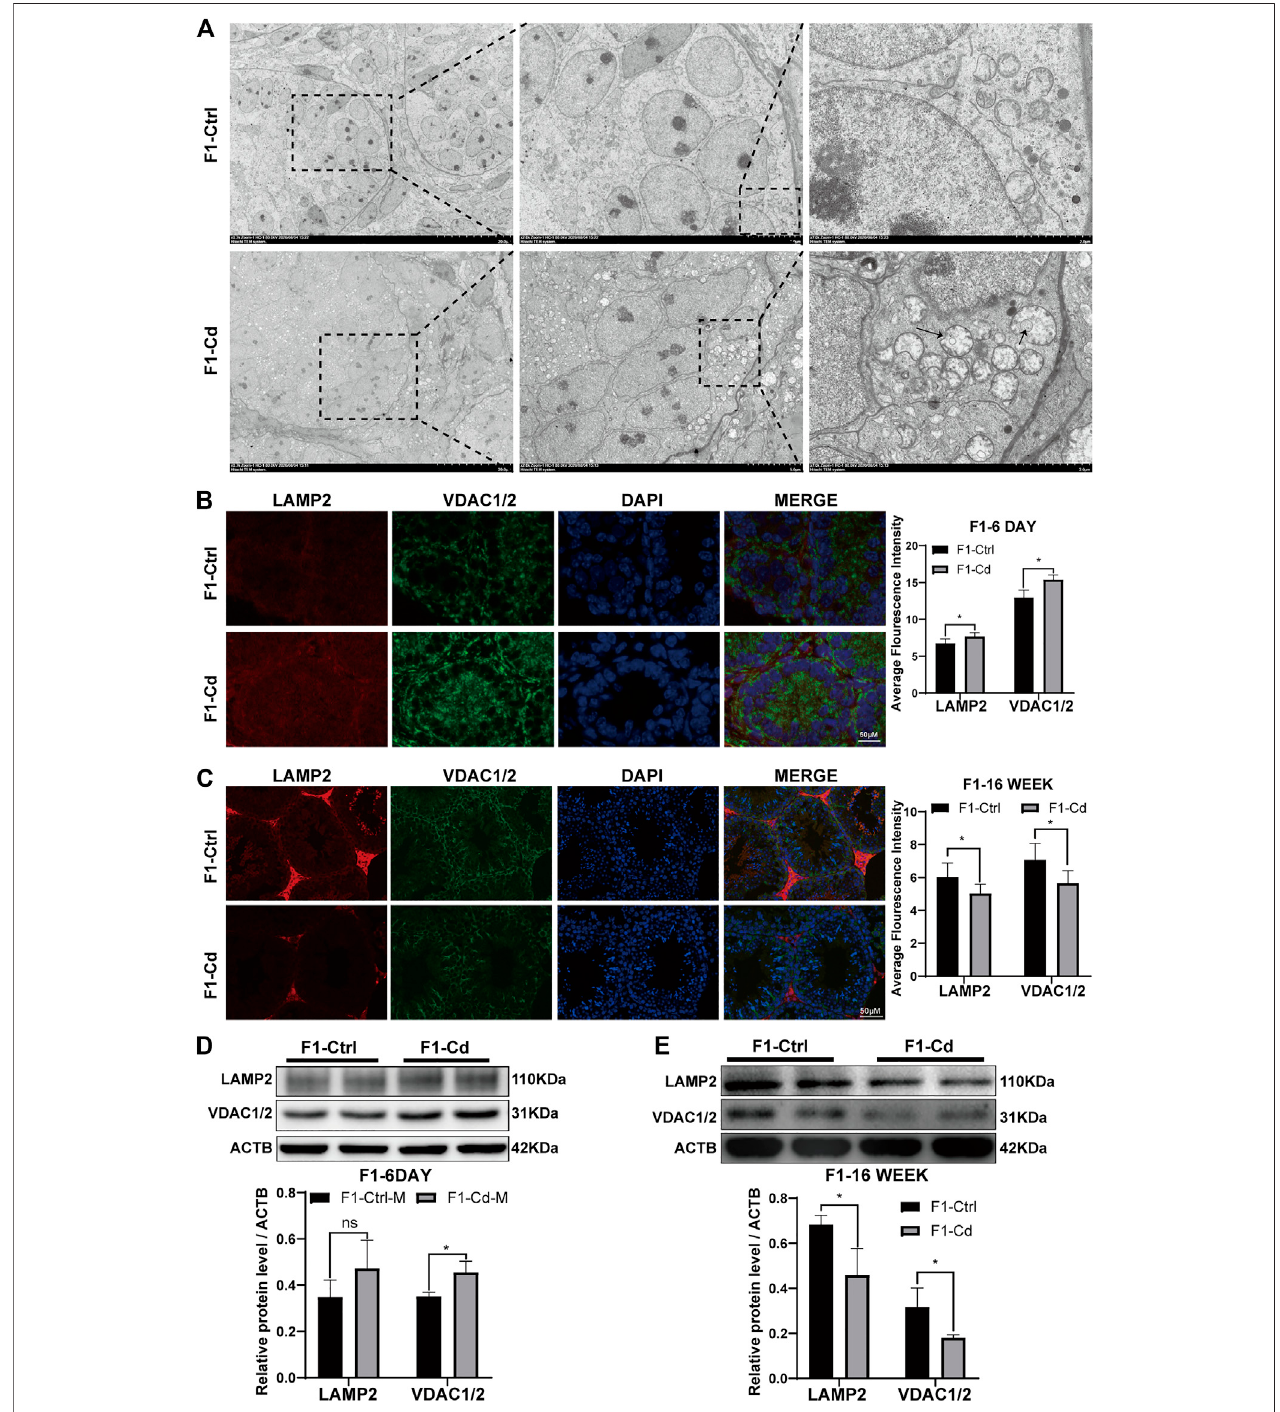
FIGURE 6 | Effects of Cd exposure on progeny testis. (A) Transmission electron microscopy (TEM) results of the testes in mice. The black arrows manifest the mitochondrial vacuole, accompanied by the decreased mitochondrial cristae. (B) The immuno fl uorescence and quanti fi cation analysis of LAMP2 and VDAC1/2 in the testesofF1miceat6 daysafterbirth(scalebar (cid:1) 50 μ m, n (cid:1) 3). (C) Theimmuno fl uorescenceandquanti fi cationanalysisofLAMP2andVDAC1/2inthetestesofF1mice at 16weeks(scalebar (cid:1) 50 μ m, n (cid:1) 3). (D) Theprotein levelsofLAMP2and VDAC1/2inmice testiculartissueat 6 days weremeasured bywesternblotting( n (cid:1) 3). (E) The protein levels of LAMP2 and VDAC1/2 in mice testicular tissue at 16 weeks were measured by western blotting ( n (cid:1) 3). All results are expressed as the mean ± SD. Labeled asterisk represents statistical signi fi cance compared with the respective control group. * p < 0.05, ** p < 0.01, *** p < 0.001 and **** p < 0.0001, ns, no signi fi cant